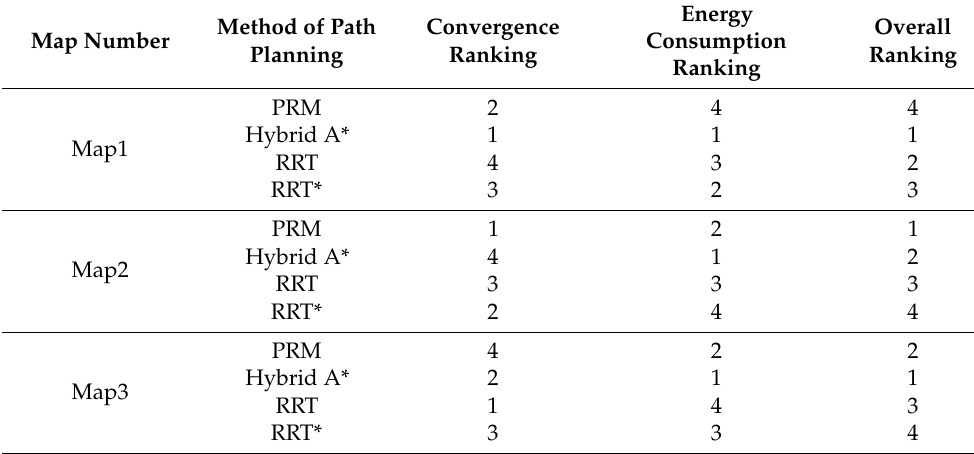
Table 3. The ranking table of the applied algorithms on three indoor maps. Method of Path Map Number Planning